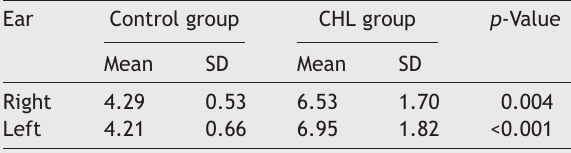
Comparison of the GIN threshold (ms) between the control and Conductive Hearing Loss (CHL)